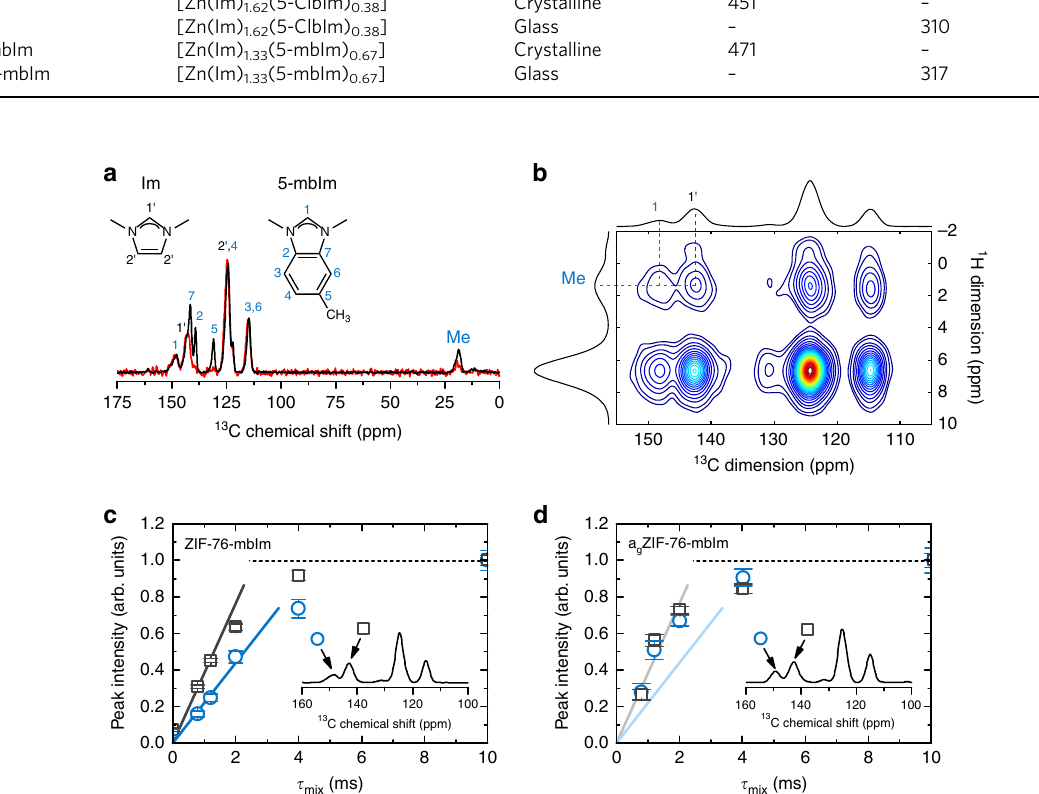
Fig. 2 Linker dynamics upon melting. a The 13 C MAS (black solid line) and 1 H- 13 C Lee – Goldburg cross-polarization MAS (red solid line) NMR spectra of crystalline ZIF-76-mbIm. Tentative assignment of individual signals is based on literature data for isotropic chemical shifts from the two molecular fragments. The assignment is further con fi rmed by comparing the resonances in the 13 C MAS and 1 H- 13 C Lee – Goldburg cross-polarization MAS NMR spectra. In the latter, only resonances belonging to those carbons with hydrogens attached can be observed. b The 13 C-detected 2D spin-diffusion NMR spectrum, recorded with a mixing time of 10 ms. Cross peaks due to polarization transfer between methyl protons of 5-mbIm on one hand and H1 ’ protons of Im and H1 protons of 5-mbIm on the other are denoted. c , d Spin-diffusion curves from the 13 C-detected measurements on ZIF-76-mbIm and a g ZIF-76- mbIm (squares: inter-linker polarization transfer between methyl protons of 5-mbIm and H1 ’ protons of Im; circles: intra-linker polarization transfer between methyl and H1 protons of 5-mbIm). Solid lines in c and d indicate the initial slopes of the two spin-diffusion curves for crystalline ZIF-76-mbIm (i.e., lines in d are equal to lines in c )